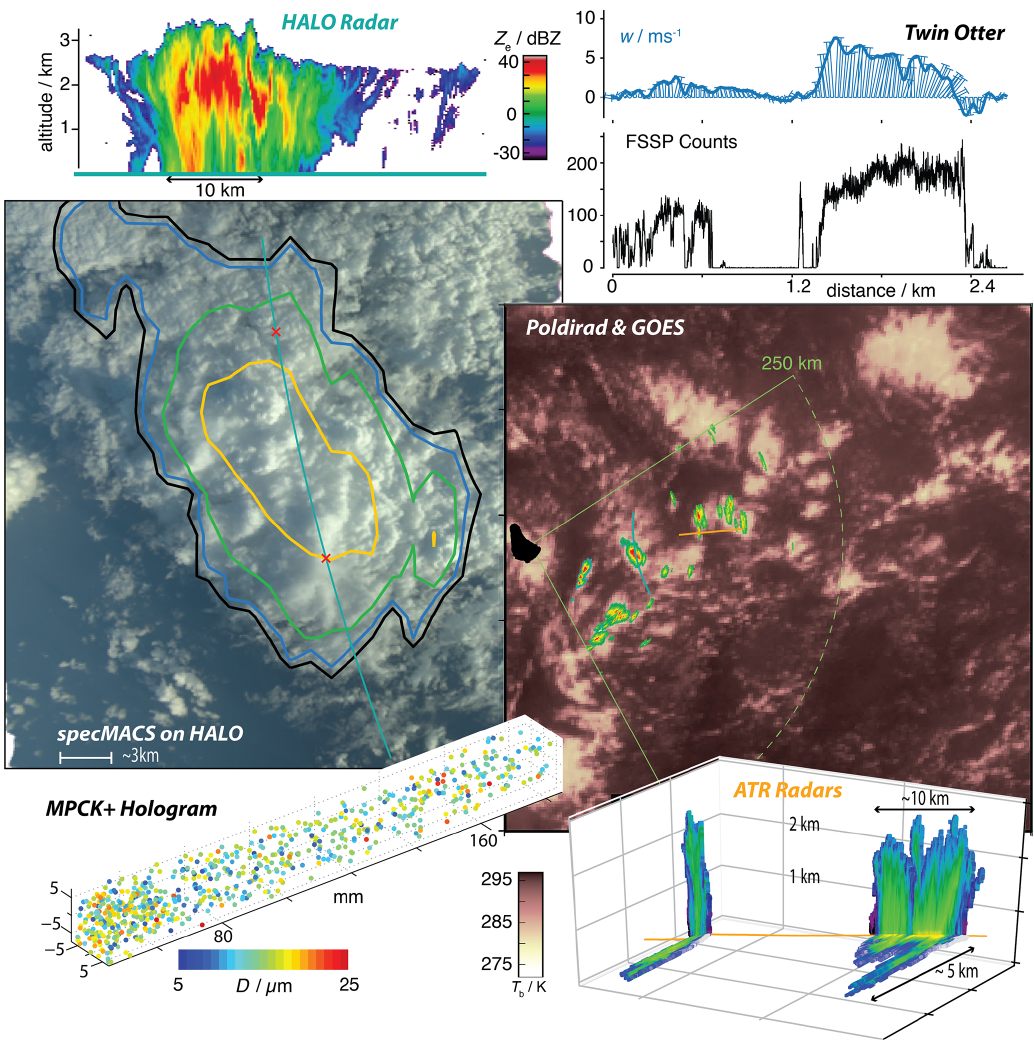
Figure 11. Measurements within the Tradewind Alley test section (5 February) define a multi-scale cloud chamber. The figure highlights clustering on different scales. Scanning C-band radar (POLDIRAD) 0.6 ◦ scan (11:25:25UTC) is overlain on the 11:33:41UTC brightness temperature (at 10.6µm) measured by GOES-16, with coincident segments of the HALO and ATR flight tracks. Radar images from the ATR (horizontal and zenith) and HALO (nadir) are shown (all radar imagery shares the same color scale), as well as cloud water and updraft velocity from a penetration of cloud by the Twin Otter (later in the day, at 18:32UTC, near 13.55 ◦ N, 58.26 ◦ W at 1910m). Visual image from the specMACS instrument, with POLDIRAD reflectivity contours superimposed, shows the cloud visualization along a segment of the HALO flight track. MPCK+ hologram measurements (made in the southern portion of the circle – 12.25 ◦ N, 57.70 ◦ W at 1084m – on 17 February) demonstrate the capability to measure the three-dimensional distribution of individual cloud droplets colored by